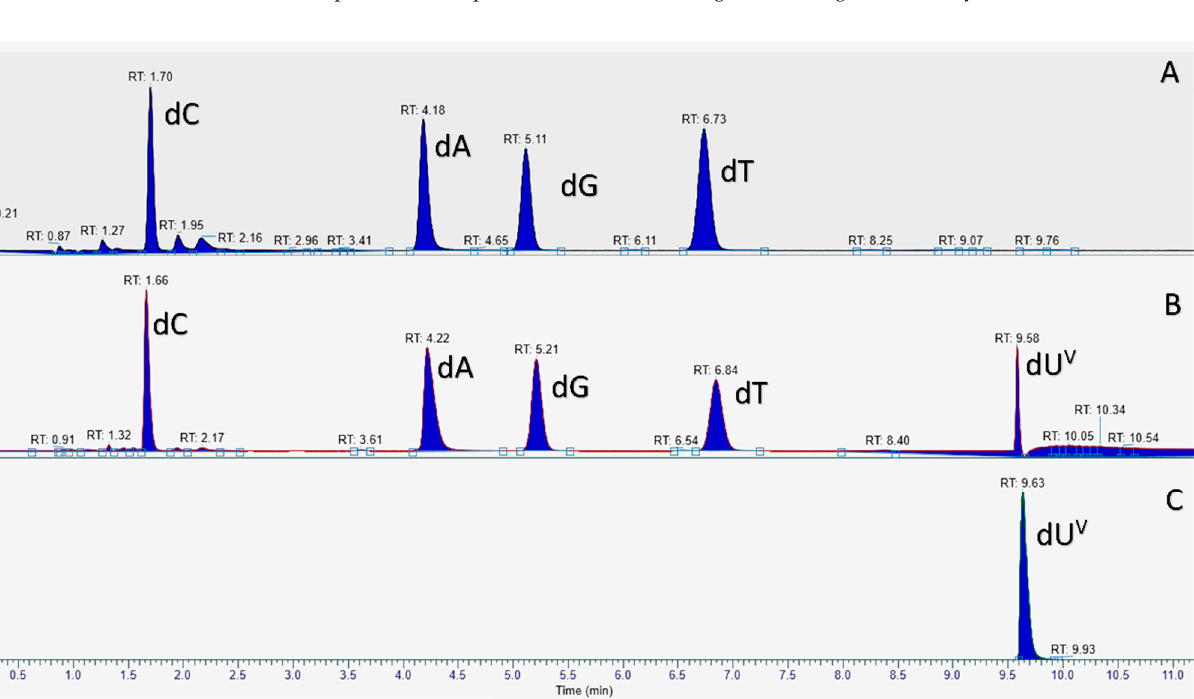
a italicized letters represent primer binding sites and bold, red letters indicate sites where modified nucleotides can be incorporated. N40 represents the randomized region of the degenerate library.